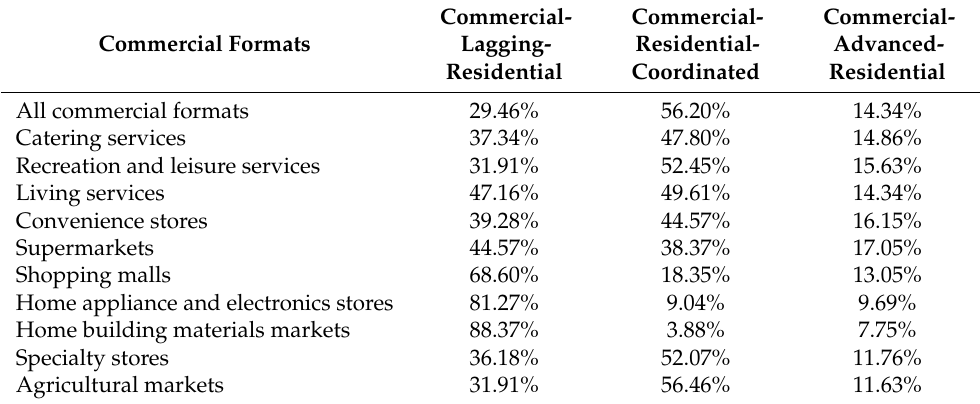
Table 7. The proportion of each association type of commercial and residential